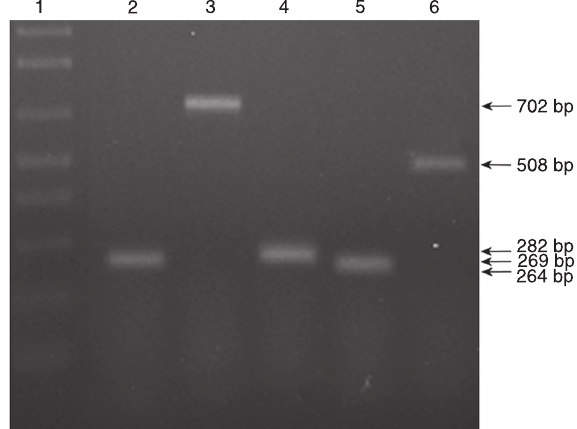
Figure 1. Detection of β2 integrin and its α subunit partners in ED13.5 embryonic mouse hearts by RT-PCR. Integrin subunit expression was analyzed in ED13.5 embryonic mouse hearts by RT-PCR with specific primers: Lane 1 , 1-kb DNA ladder; Lanes 2 and 3, the presence of β2 integrin was confirmed by using two different sets of primers, which generated the expected bands of 269 or 702 bp; Lane 4 , αL (CD11a) 282 bp; Lane 5 , αM (CD11b) 264 bp; Lane 6 , αX (CD11c) 508 bp. No bands were detected in control reactions prepared without template, or reverse tran- scriptase, or primers (data not shown). ED = embryonic